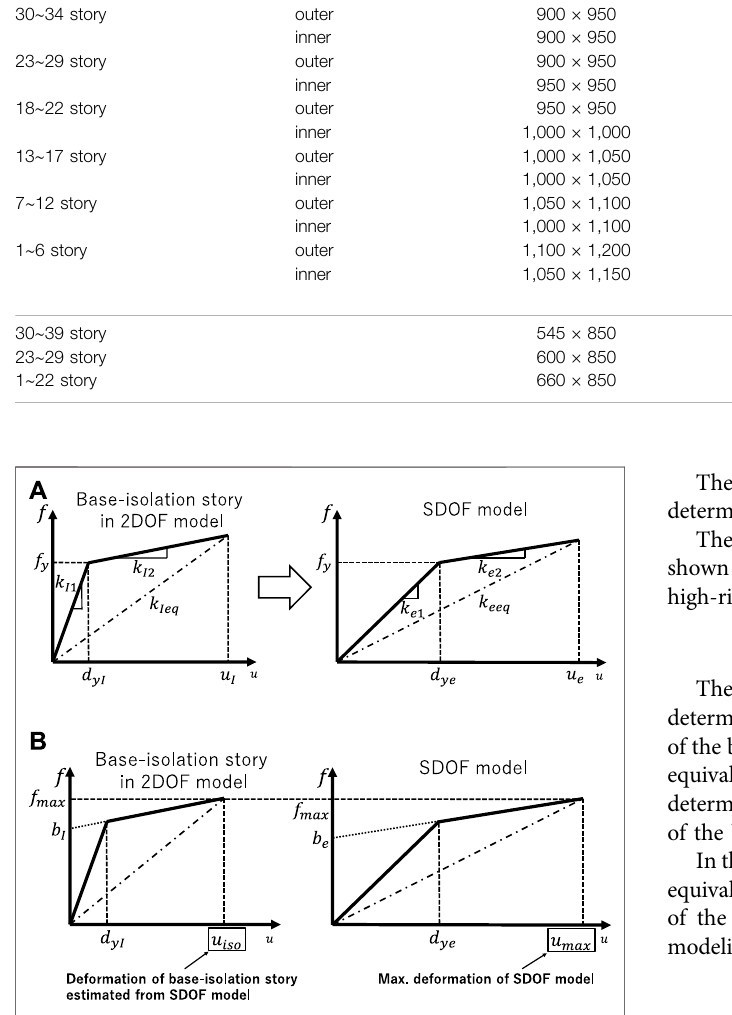
FIGURE 4 | Transformation from 2DOF model into SDOF model, (A) Force-deformation relation ofabase-isolation story in2DOF model and thatin SDOF model, (B) Evaluation of deformation of the base-isolation story in SDOF model.